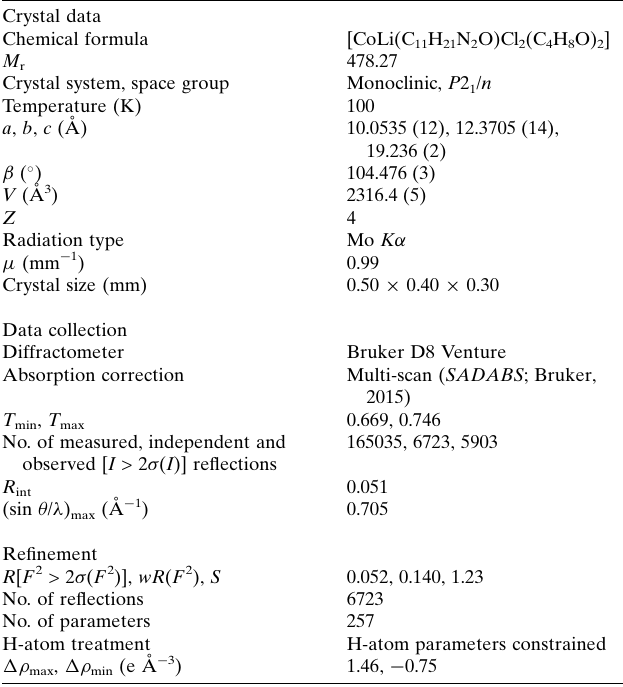
Table 3 Experimental details. Crystal data Chemical formula